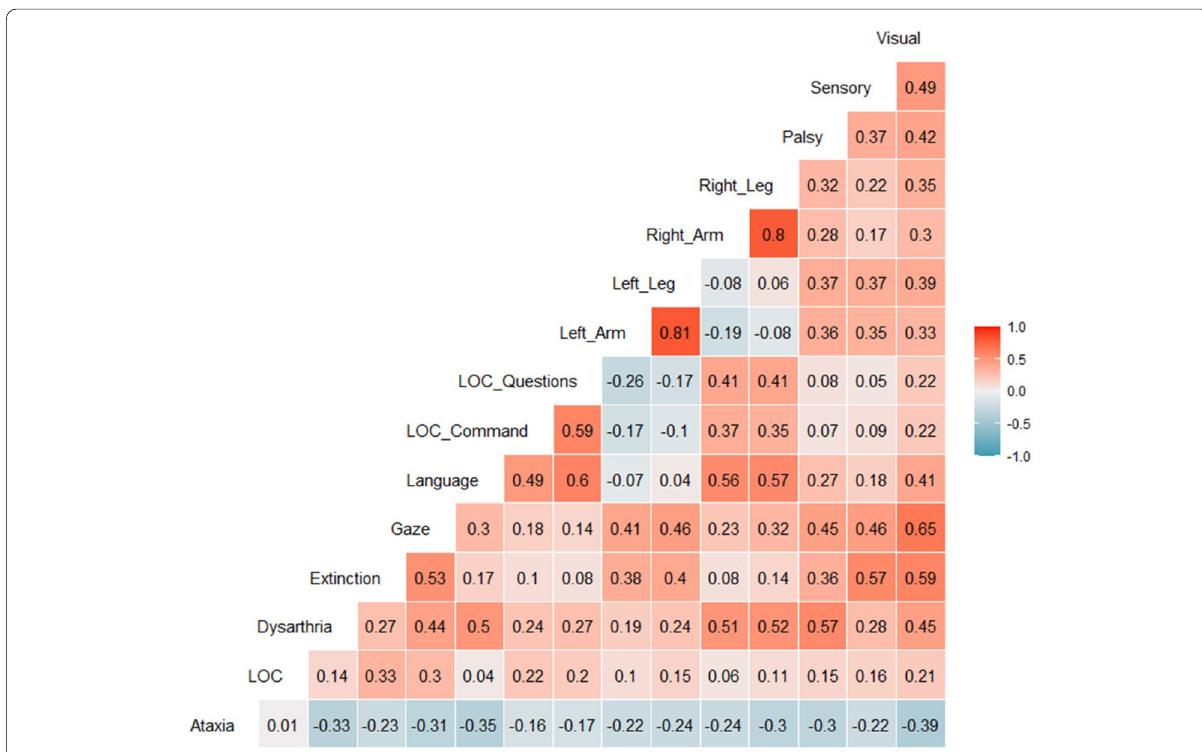
Fig. 2 Correlogram showing the association between slopes in the different domains of the NIHSS. Correlations are shown as Spearman rank-order correlations. Red boxes indicate positive correlations and blue colors indicate negative